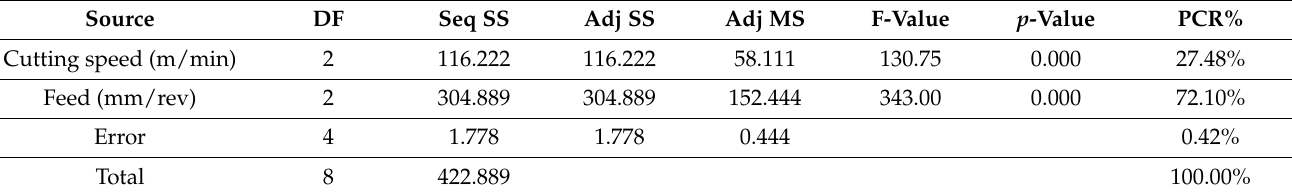
Figure 11. Main effects plots for tool life. Table 5. ANOVA analysis relative to tool